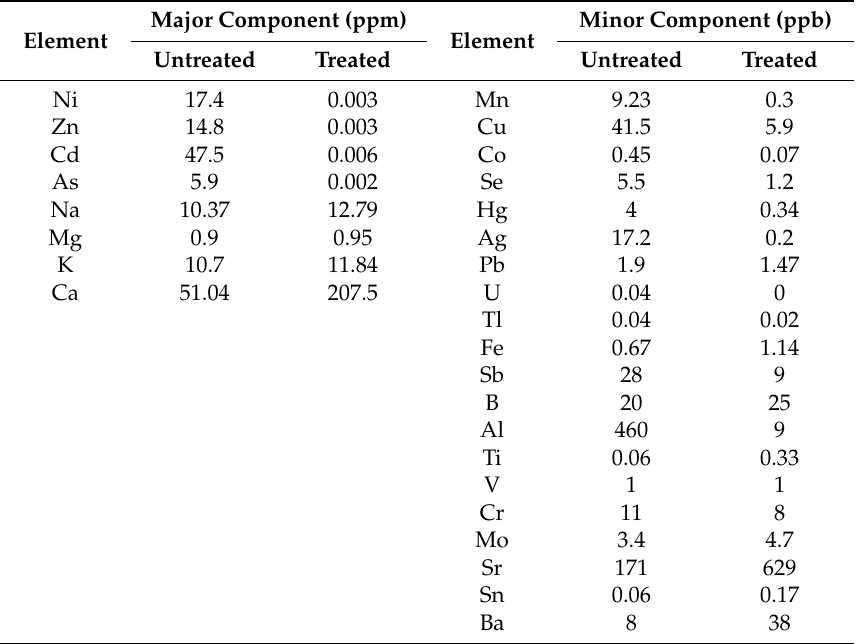
Table 6. Metal concentrations analyzed by ICP of untreated leachate and leachate treated with bottom ash during 15 min.